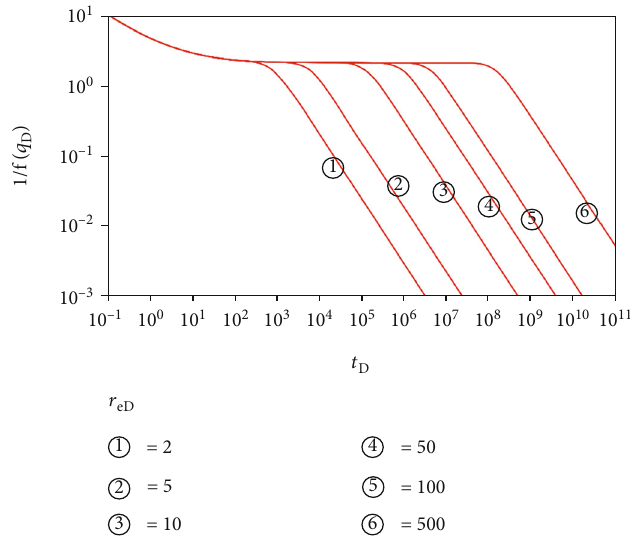
Þ vs. t D for a homogenous D